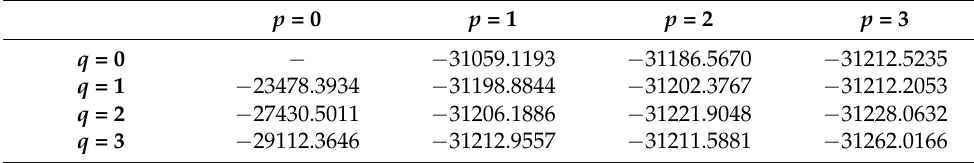
Table A9. AIC values of z -axis BiLSTM network results at each order.